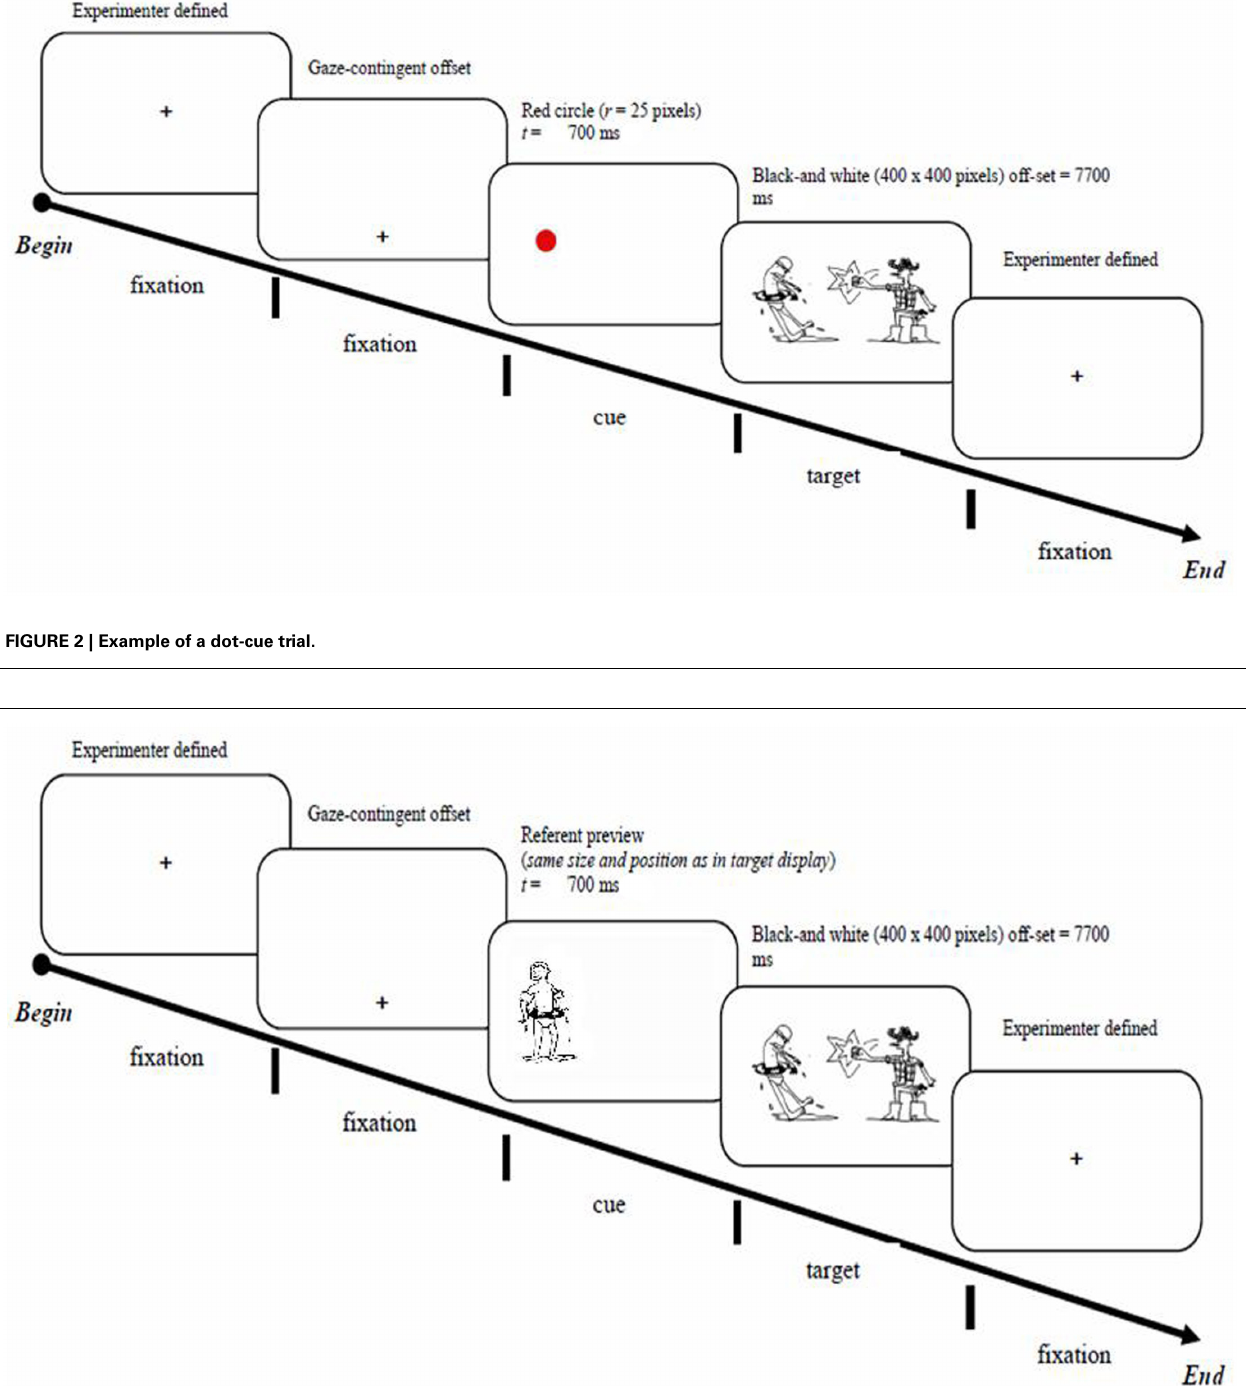
FIGURE 3 | Example of a referent-cue trial.